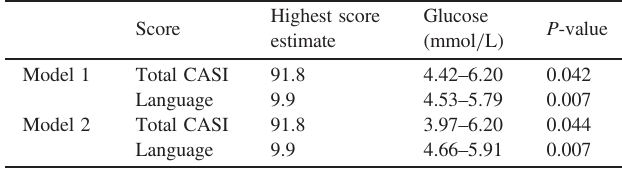
Table 3. Estimated fasting blood glucose range associated with the highest total and domain CASI scores from the reverse U-shaped relationship in non-diabetic men